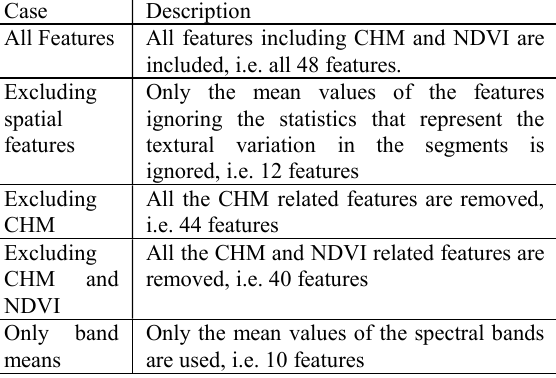
Table 2. Different combinations of features in the analysis